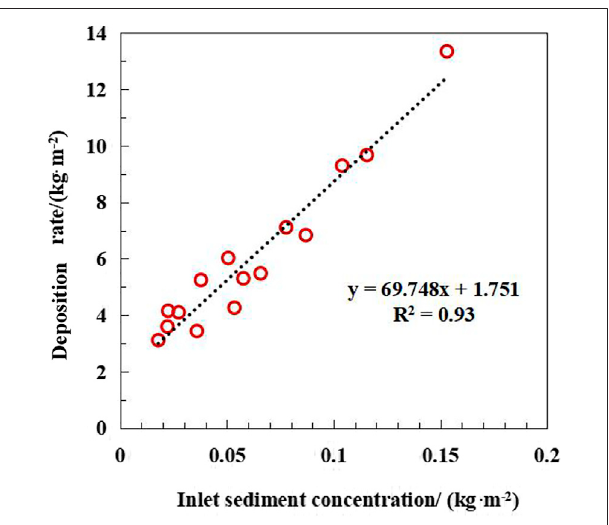
FIGURE 8 | Variation of the basin fl oor sediment concentration with the inlet sediment